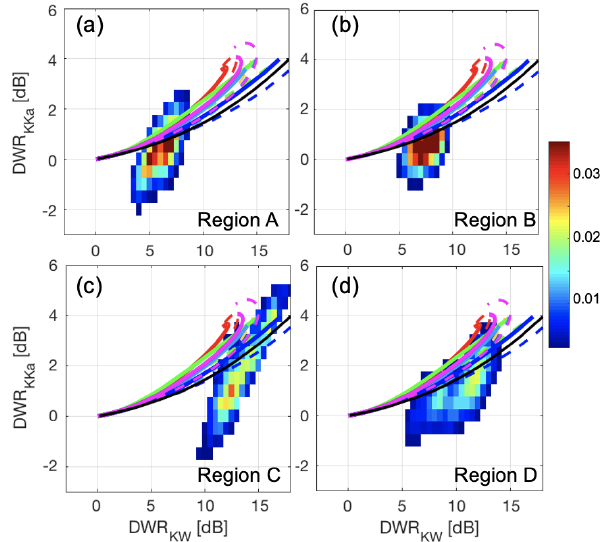
Figure 7. (a) – (d) DWR KKa -versus-DWR KW diagrams for regions A, B, C, and D, respectively. Color shades represent normalized frequency. Lines in each panel represent the SSRGA calculations using particle type and PSD models described in Appendix A. The color line legend is the same as in Fig. 1a, and black lines are same as black lines in Fig. 1b.